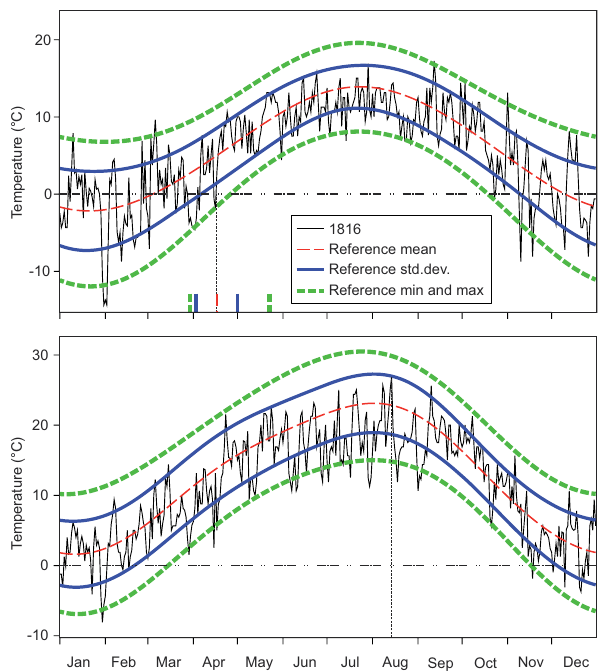
Fig. 2. Time series of daily values of temperature at sunrise (top panel) and 14:00LT (bottom panel) in the year 1816 (thin black solid line) as well as for the average of the reference period (red dashed line). The blue (solid bold) lines denote ± 1 standard devia- tion from the mean; the green (dashed bold) lines give the minima and maxima for the reference period. Note that all annual cycles from the reference period were obtained from the statistics for each calendar day. They were then smoothed by fitting the first two har- monics of the annual cycle. The black dotted vertical line in the up- per panel indicates the last day of morning temperatures in spring below 0 ◦ C in 1816. Ticks on the x-axis indicate the mean last day- of-year with morning temperatures below 0 ◦ C in the reference pe- riod (red dashed tick), ± 1 standard deviation (blue solid bold ticks), and the earliest and latest date with negative spring temperatures in the morning (green dashed bold ticks). The black dotted vertical line in the lower panel indicates the date of the annual maximum temperature in 1816.